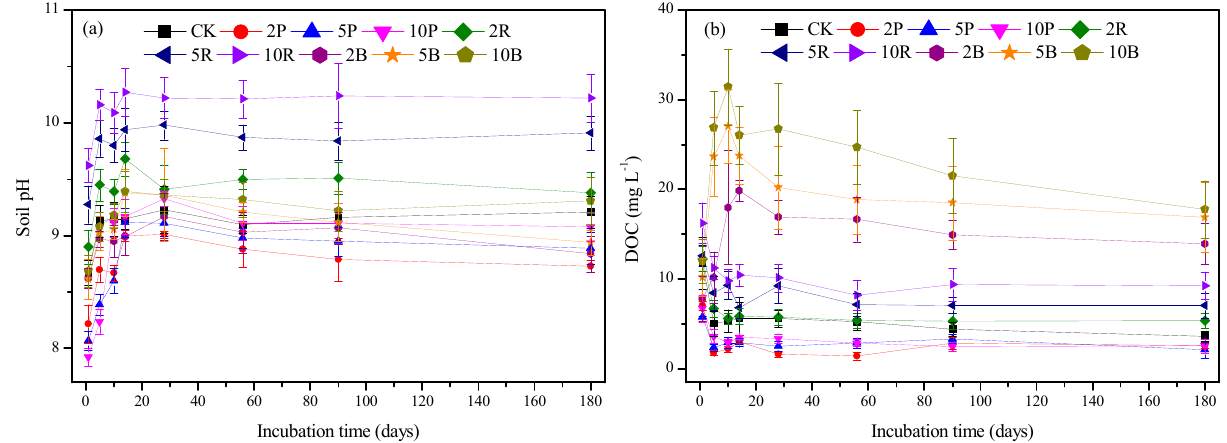
Figure 1. Changes in soil pH ( a ) and DOC concentration ( b ) over 180 days incubation with phosphate, red mud, and biochar (CK: control; 2P: 2% phosphate; 5P: 5% phosphate; 10P: 10% phosphate; 2R: 2% red mud; 5R: 5% red mud; 10R: 10% red mud; 2B: 2% biochar; 5B: 5% biochar; 10B: 10% biochar). Error bars represent ± standard error.